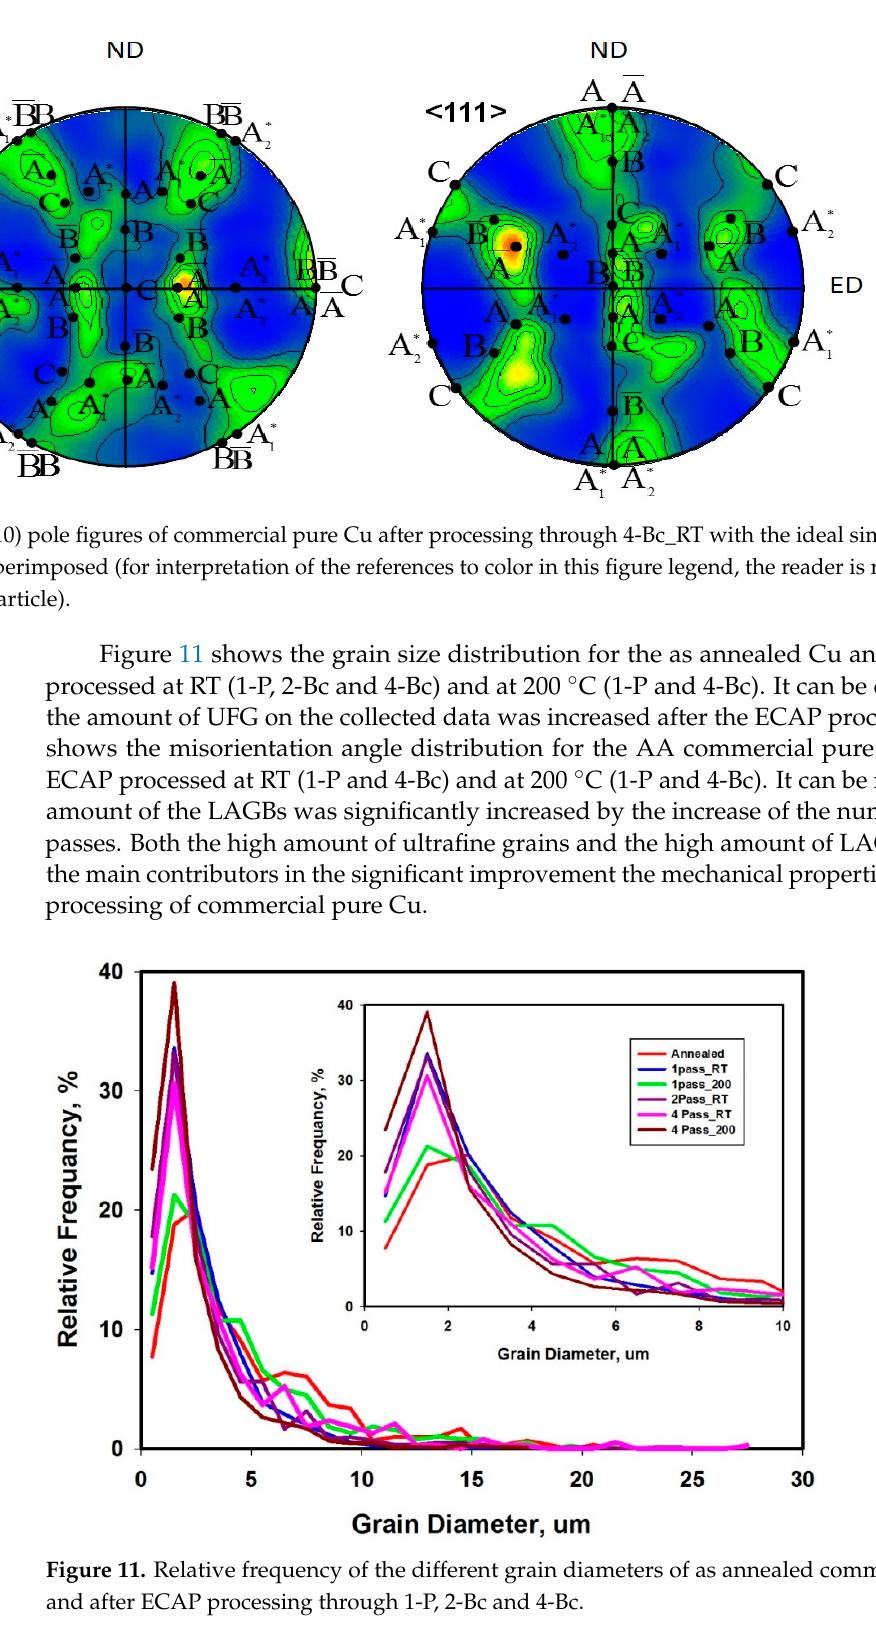
Figure 9. (110) and (111) pole figures of commercial pure Cu for the ( a ) AA, ( b ) 1-P_RT, ( c ) 2-Bc_RT, ( d ) 4-Bc_RT, ( e ) 1-P_200 °C and ( f ) 4-Bc_200 °C samples (for interpretation of the references to color in this figure legend, the reader is referred to the web version of the article).